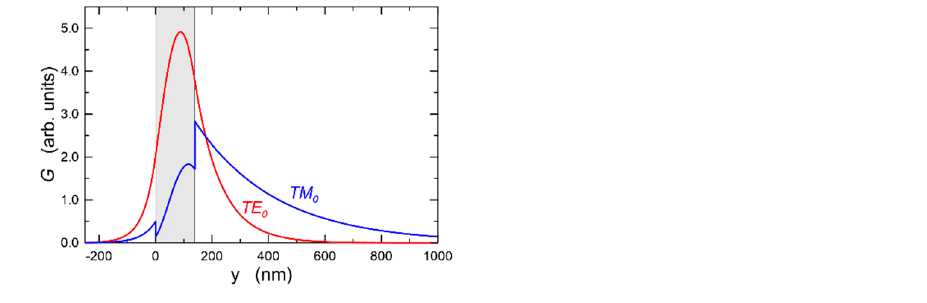
Figure 16. Distribution of the power density in the slab waveguide n b -n 1 -n c = 1.51-1.94-1.00, d = 146